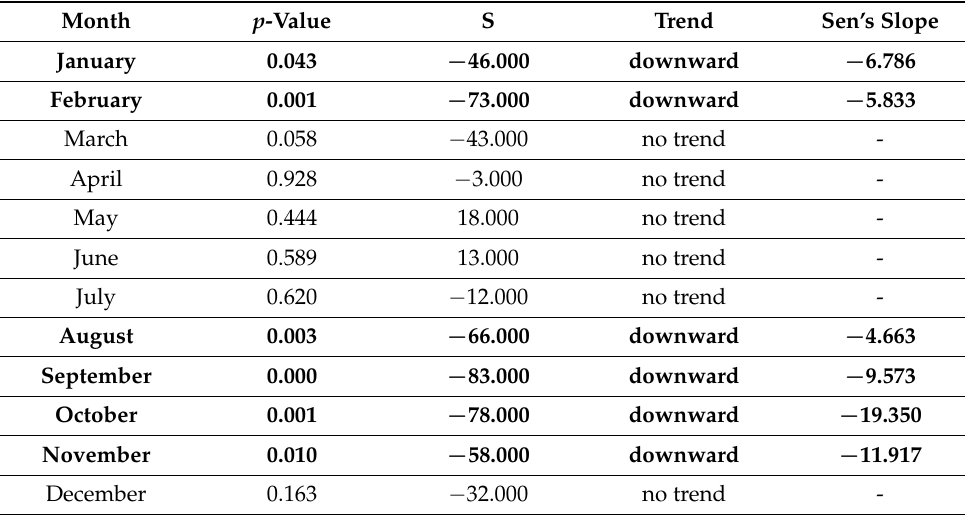
Table 4. Mann–Kendall trend analysis for